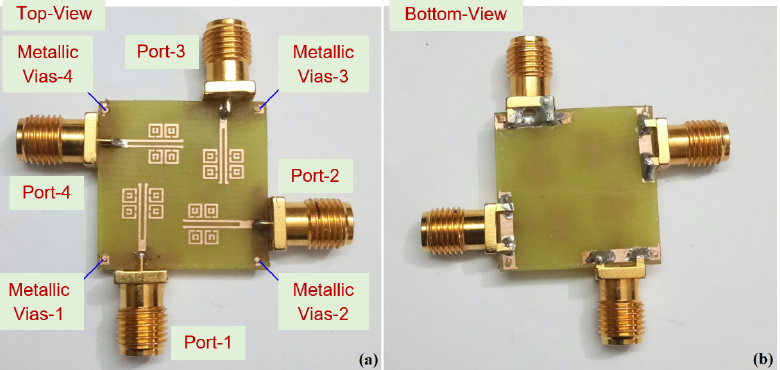
Figure 10. Fabricated prototype of the proposed four-element antenna: ( a ) top view and ( b ) bottom